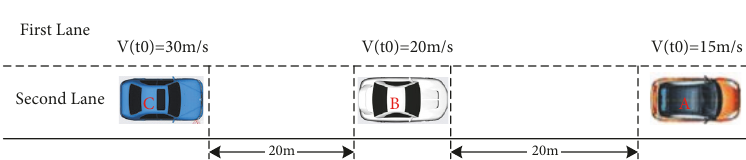
Figure 6: More than scene of vehicle cooperative lane change.